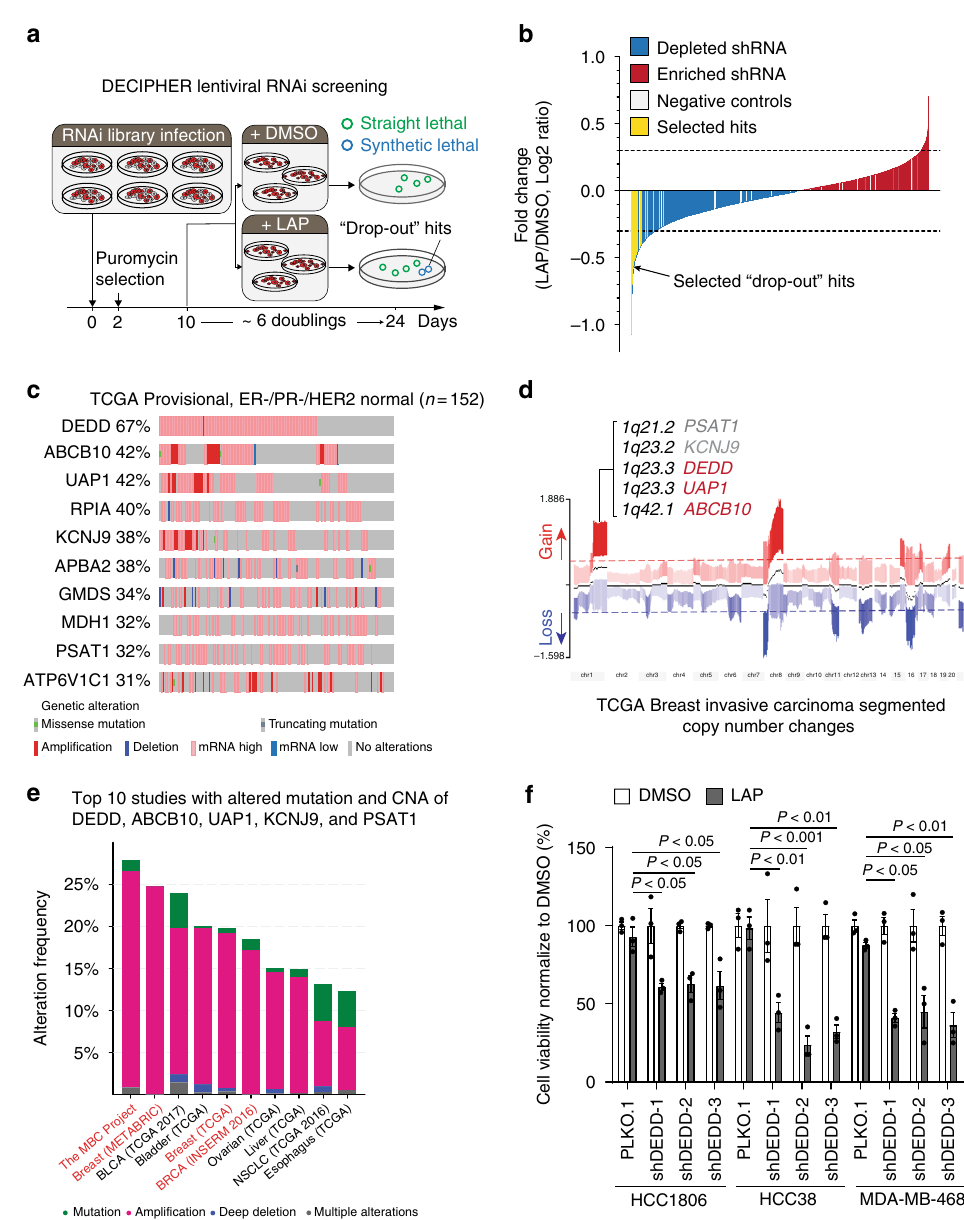
Fig. 1 Death effector domain-containing DNA-binding protein ( DEDD ) upregulation confers a vulnerability to epidermal growth factor receptor/human epidermal growth factor receptor 2 (EGFR/HER2) inhibitor. a Schematic representation of the synthetic lethal bar-coded short hairpin RNA (shRNA) drop- out screen using triple-negative breast cancer (TNBC) cell line HCC1806 with the EGFR inhibitor lapatinib (LAP) treatment. b Bar-coded shRNAs enriched or depleted in the LAP-treated HCC1806 cells compared with dimethyl sulfoxide (DMSO)-treated cells. The bar-coded shRNAs of the top 200 depleted genes in LAP-treated cells were considered as drop-out hits (MAGeCK method, colored yellow). c Genetic and epigenetic alterations of the top 10 genes among top 200 depleted genes that are upregulated in estrogen-negative/progesterone receptor-negative/HER2 (ER − /PR − /HER2) normal tumors ( n = 152) found within the Cancer Genome Atlas (TCGA). d Segmented view of the copy-number changes of DEDD , ABCB10 , UAP1 , KCNJ9 , and PSAT1 in TCGA breast-invasive carcinoma tumors. e Genome alteration frequency plot of top 10 cancer studies with DEDD , ABCB10 , UAP1 , KCNJ9 , and PSAT1 alterations across 164 studies in cBioPortal. f Cell counting assay validating knockdown of DEDD sensitizes TNBC cells to LAP treatment (error bars: means ± s.e.m). Cells were normalized to DMSO control group in each shRNA or PLKO.1 (Control) group. All quantitative data were generated from a minimum of three replicates. P values were derived from one-way analysis of variance (ANOVA) with Dunnett ’ s multiple comparison test comparing different shRNAs to the PLKO.1